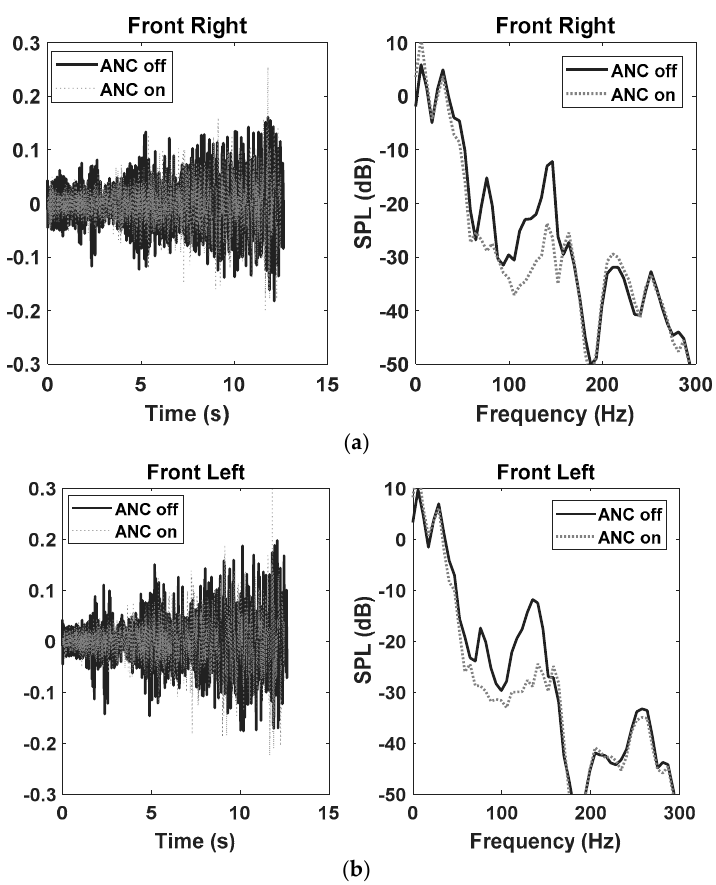
Figure 18. Performance of the ANC system with the new algorithm for full load condition of the engine. ( a ) Left seat (driver seat) and ( b ) right seat (passenger seat) (Solid line: ANC off. Dotted line: ANC on.).